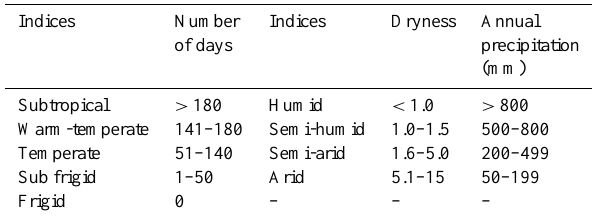
Table 1. The indices that are used to divide the TP into climate zones. Note that ET denotes annual evapotranspiration (mm), and P denotes annual precipitation (Sun and Zheng,